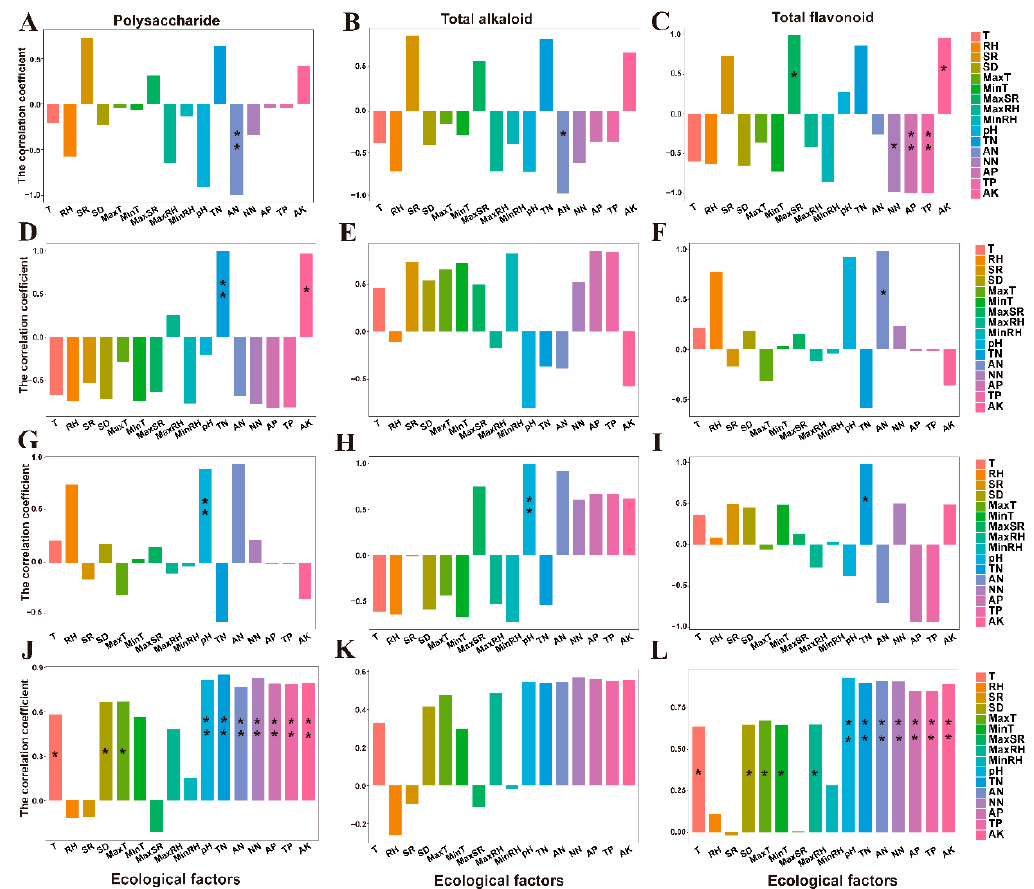
Figure 7. Correlation analysis between ecological factors and main medicinal components. ( A – C ):